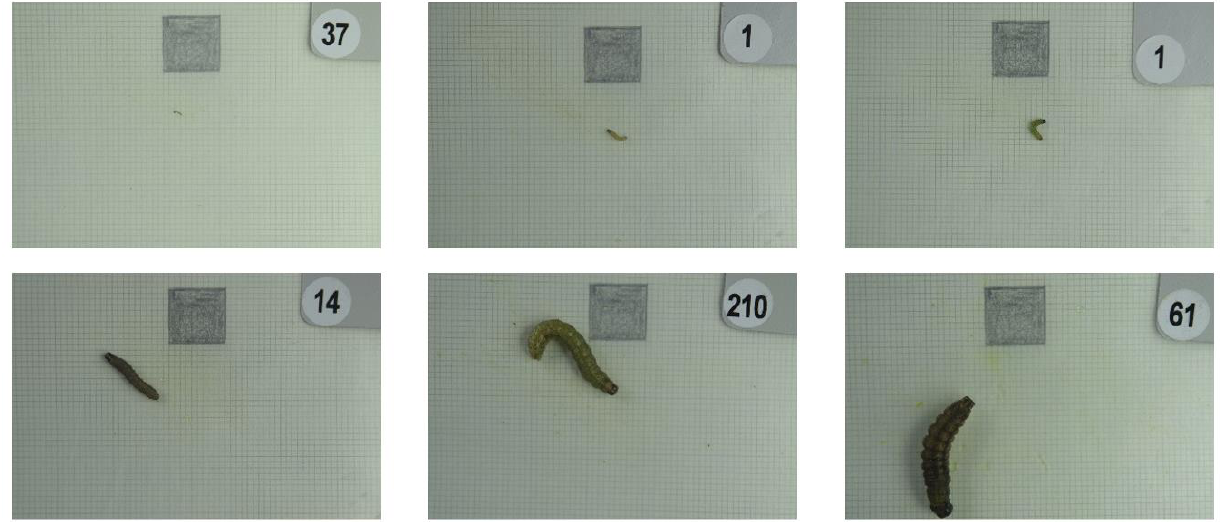
Figure 2. Images of 1st-6th instar larvae of FAW.